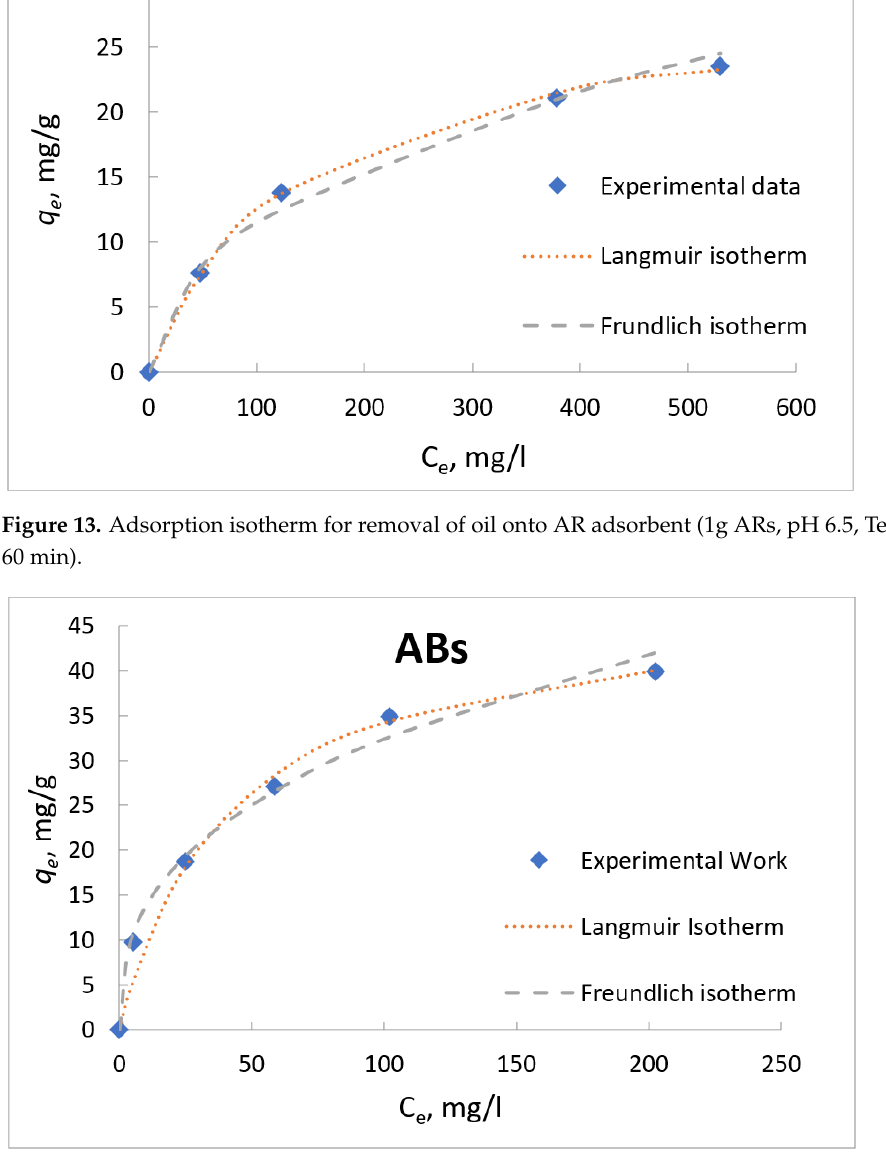
Figure 14. Adsorption isotherm for removal of oil onto AB adsorbent (1g ABs, pH 6.5, Temp. 25 °C, 60 min).